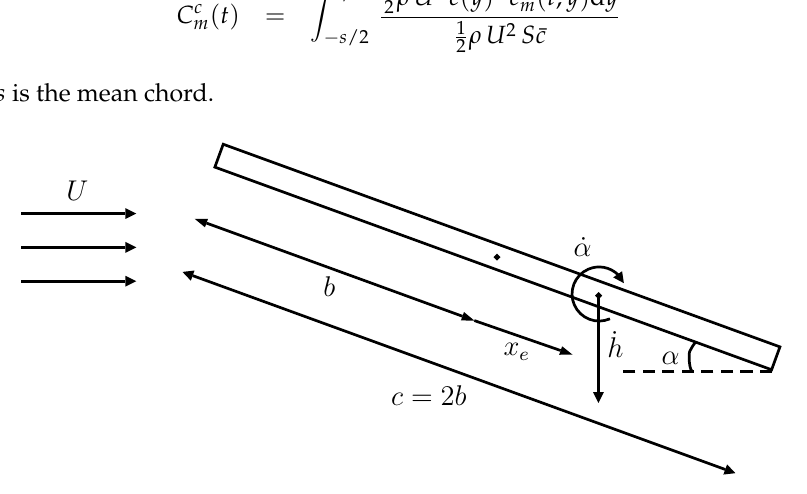
Figure 1. Rigid thin plate airfoil